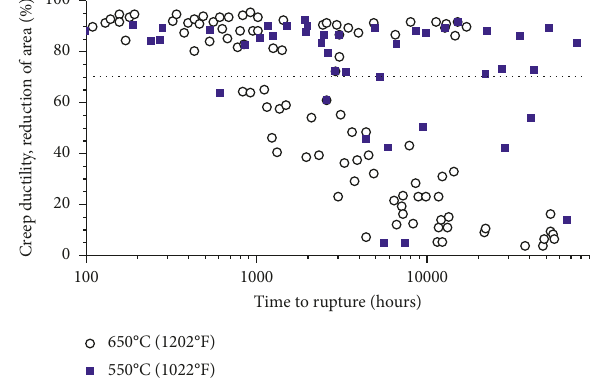
Figure 13: Creep ductility (reduction of area) for Grade 91 steel supplied by one manufacturer [40]. A dashed line is shown at 70% for the reduction of area since this was an acceptance criterion proposed by ORNL in the development of Grade 91 steel